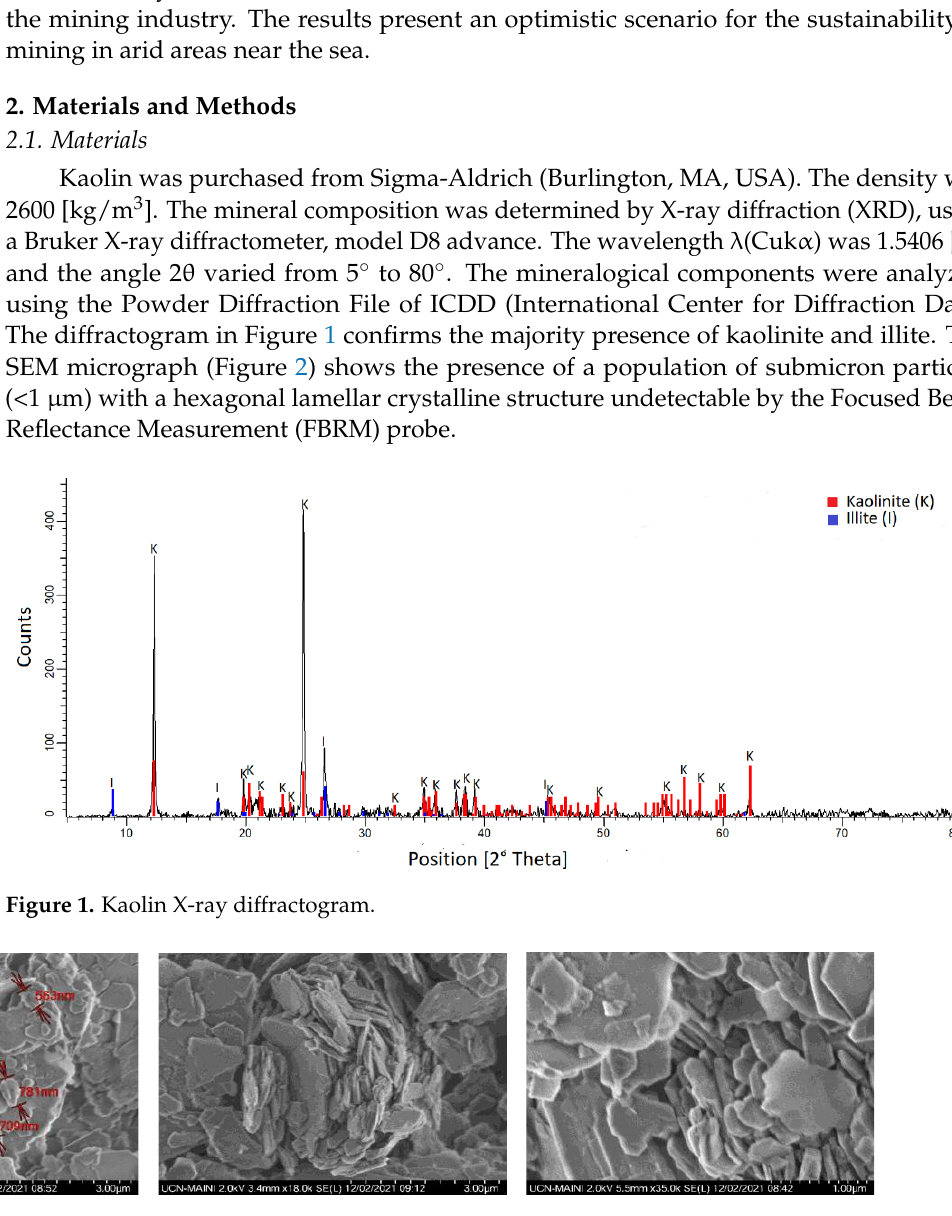
Figure 2. High-resolution SEM images showing the morphology of kaolin mineral.